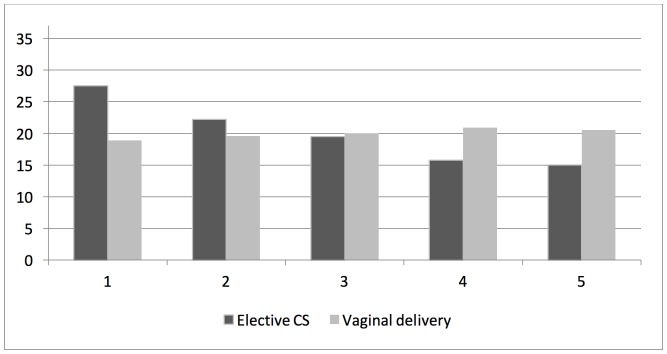
Rates (%) of TREC values in quintiles (1 = lowest quintile) after elective caesarean section and non-instrumental vaginal delivery, respectively.(Chi-square p-value<0.001).